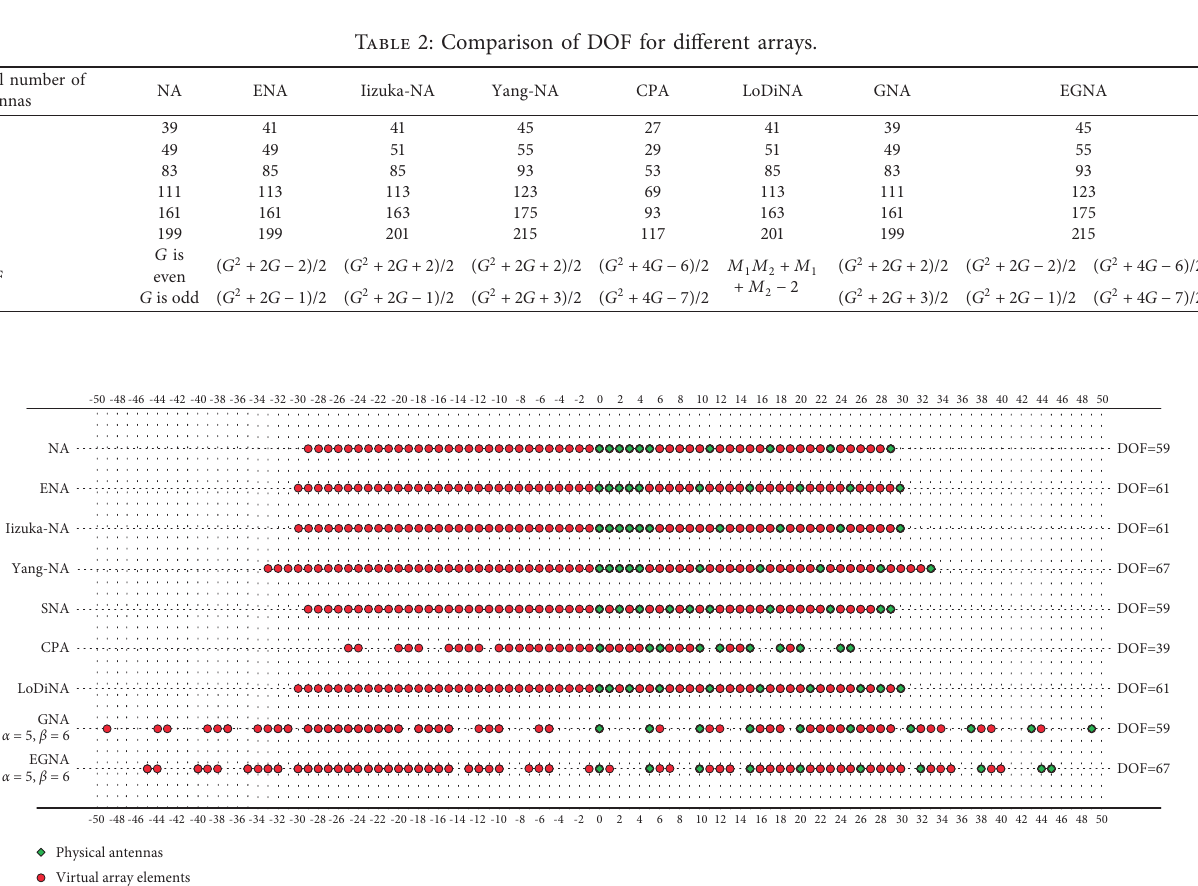
Figure 6: Schematic diagram of antenna distribution and virtual array element expansion of various arrays (the number of physical antennas is